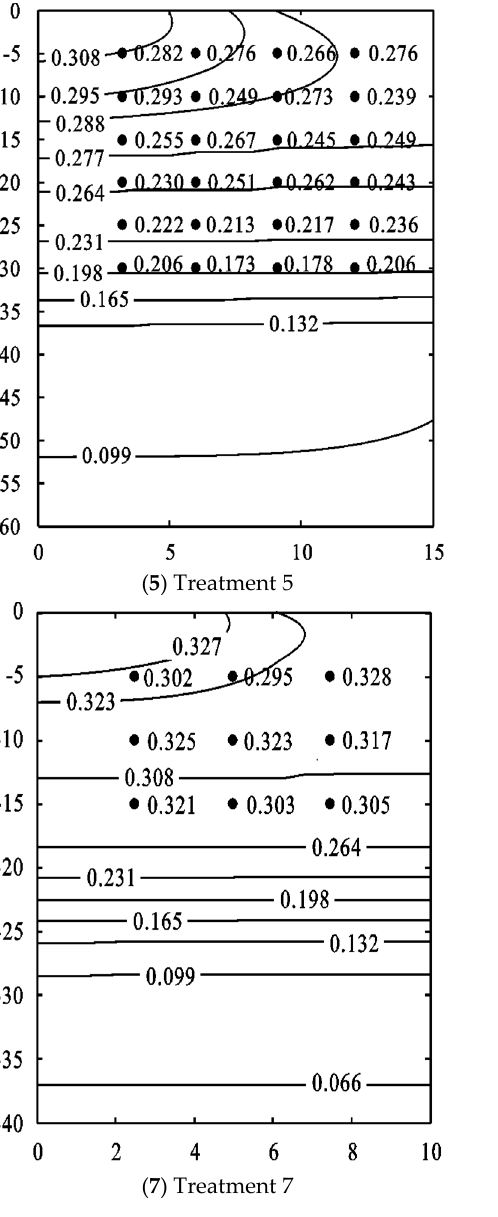
Figure 4. Comparison of simulated and measured values of soil wetting patterns (Measured data are represented by black dots, whereas simulated values are shown using water content as contour lines). Table 3. Correlation between simulated and measured SWC levels.